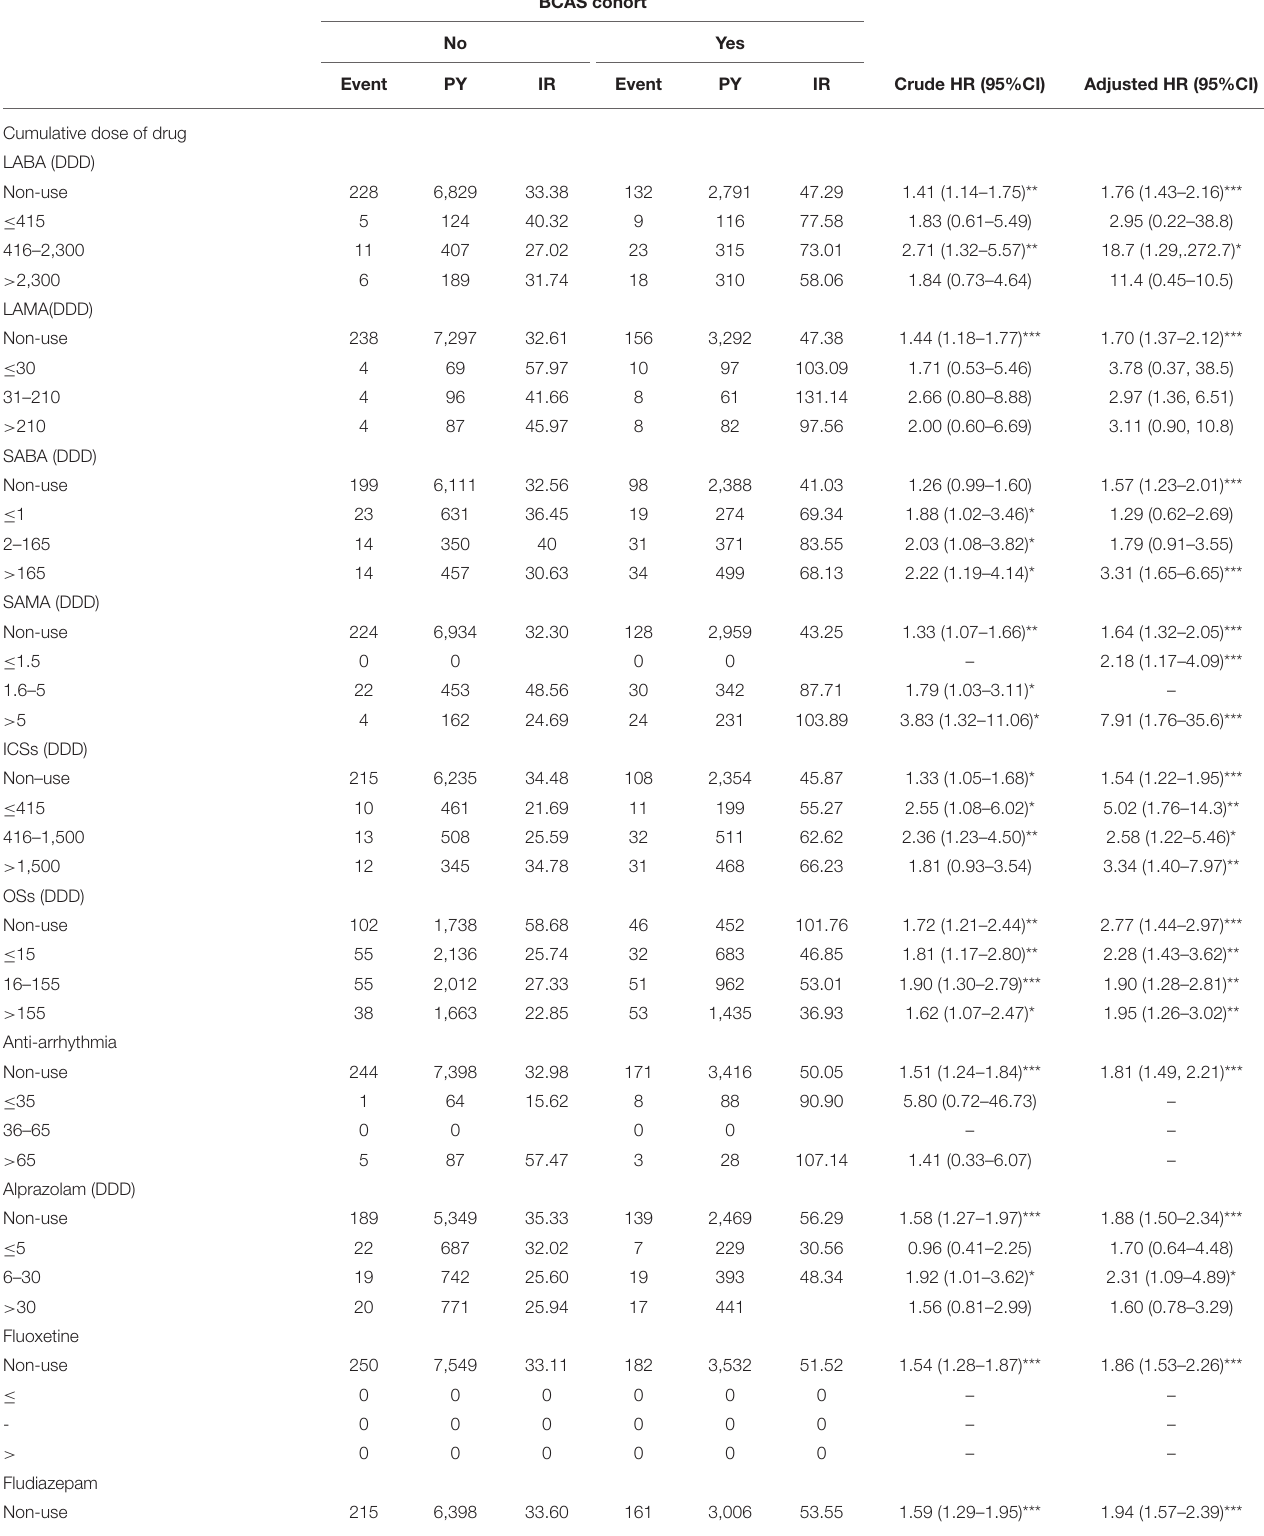
TABLE 5 | Incidence rate and hazard ratio of ischemic stroke or heart-disease between two cohorts stratified by cumulative dose of